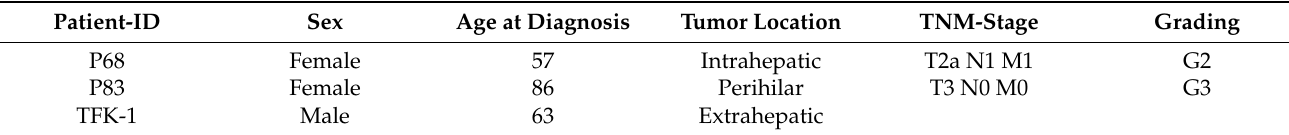
Table 2. Clinical